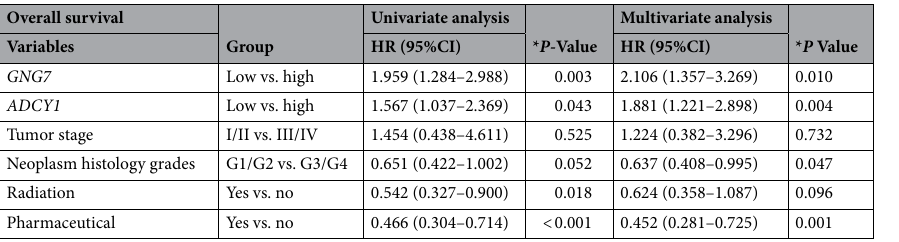
Table 3. Univariate and multivariate cox regression analysis of overall survival and recurrence-free survival (177 cases, GDC TCGA pancreatic cancer